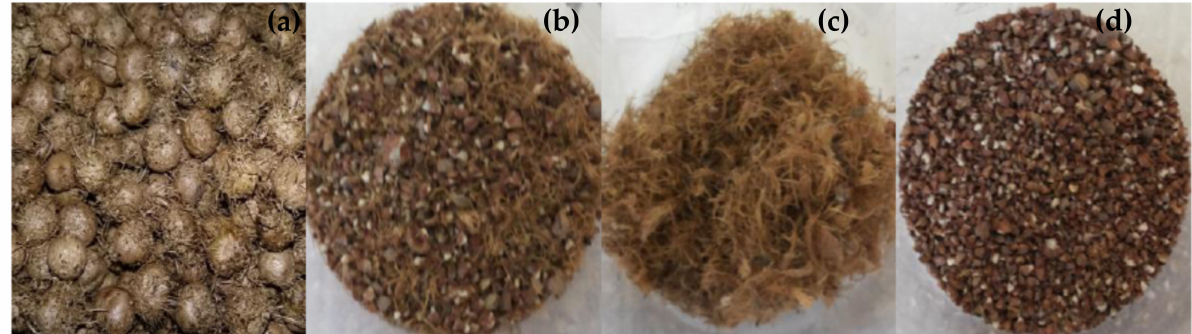
Figure 2. Material after drying, milling, and sieving process of Aça í seeds [Seeds + Fibers ( a ); Comminuted Seeds + Fibers ( b ); Fibers ( c ); and Comminuted Seeds ( d